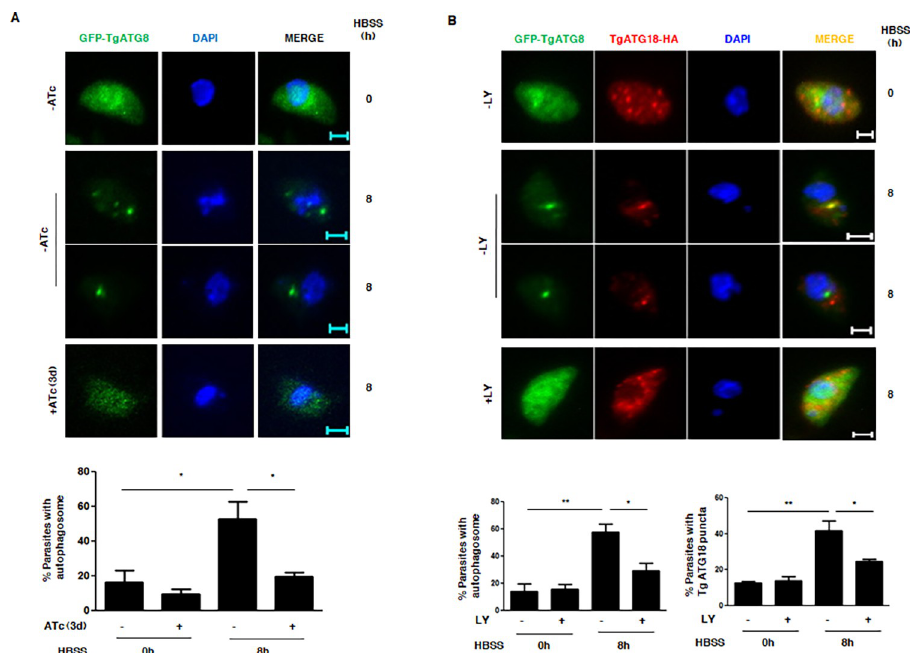
Fig 6. TgPI3K and TgATG18 regulate autophagy. A. TgATG18-iKD/GFP-ATG8 parasites were treated with ATc and extracellular tachyzoites were either cultured in complete medium (0h) or HBSS (8h) medium. Subsequently, parasites were fixed and analyzed by fluorescence microscopy. Upon ATc addition to parasites in HBSS medium, GFP-ATG8 positive autophagosomes were lost in a significant number of parasites, which were quantitated by counting at least 50 parasites (bottom panel). Data represents mean ± SE (n = 3, ANOVA, � , P < 0.05). B. TgATG18-iKD/GFP-ATG8 extracellular tachyzoites were treated with DMSO (-) or 100 μ M LY294002 and cultured in complete medium (0h) or HBSS (8h). Subsequently, parasites were fixed and analyzed by fluorescence microscopy. The number of parasites with TgATG18 or TgATG8 positive puncta was counted under each condition (bottom panel). Data represents mean ± SE (n = 3, ANOVA, �� , P < 0.01, � , P <